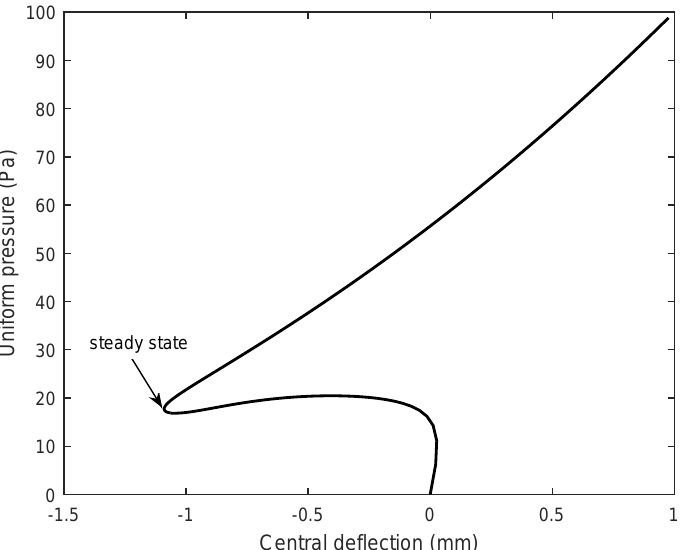
Figure 6. Central deflection of the fully clamped isotropic cylindrical membrane with h = 0.5 mm, κ =